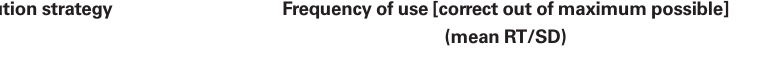
Table 1 | Solution strategies employed by RM upon solving number facts (single-digit problems). Procedural strategies (PS) are differentiated from fact retrieval (FR). For PS the various counting strategies employed by RM are described. Reported are frequency of use in % and mean reaction times (RT) with standard deviations (SD) where